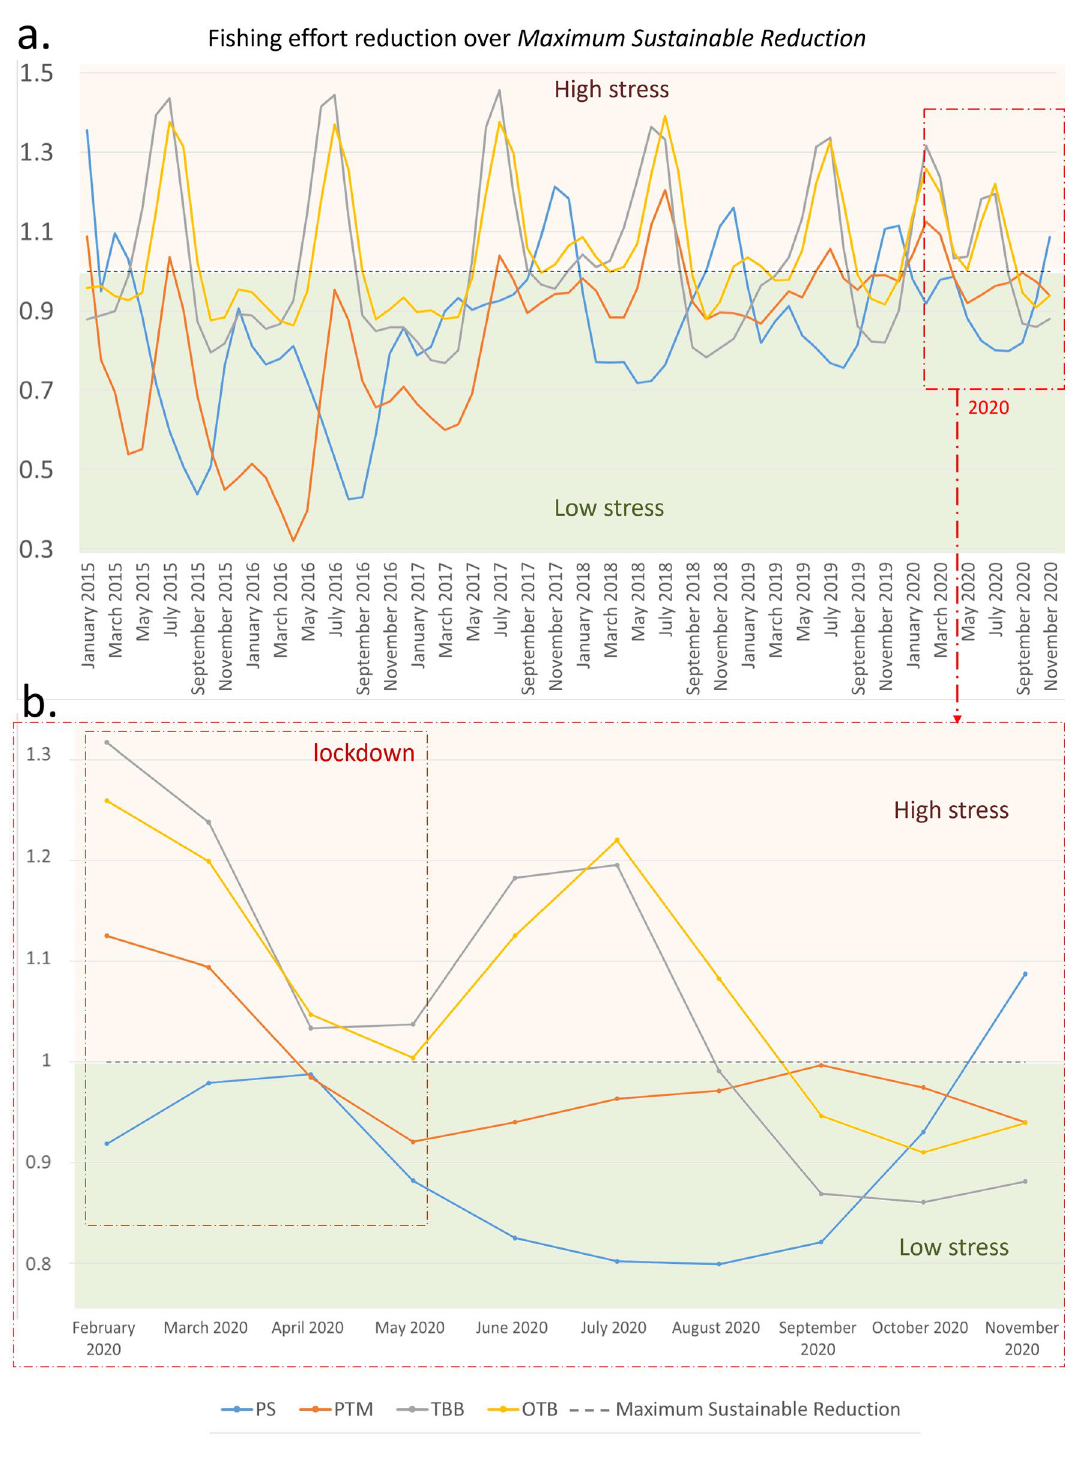
Figure 6. Fishing effort reduction divided by the maximum sustainable reduction reported for all fishing methods as estimated by AMSY: ( a ) values below the dashed line indicate low fishing hour limitation (low stress), those above the dashed line indicate strong limitation (high stress); ( b ) detailed representation of the February–November 2020 time series. Acronyms refer to the purse seine (PS), pelagic pair trawl (PTM), beam trawl (TBB) and bottom otter trawl (OTB)